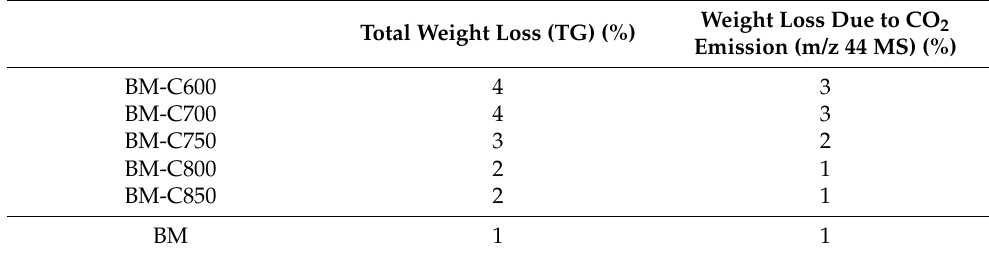
Table A3. Total weight loss calculated by TG and MS